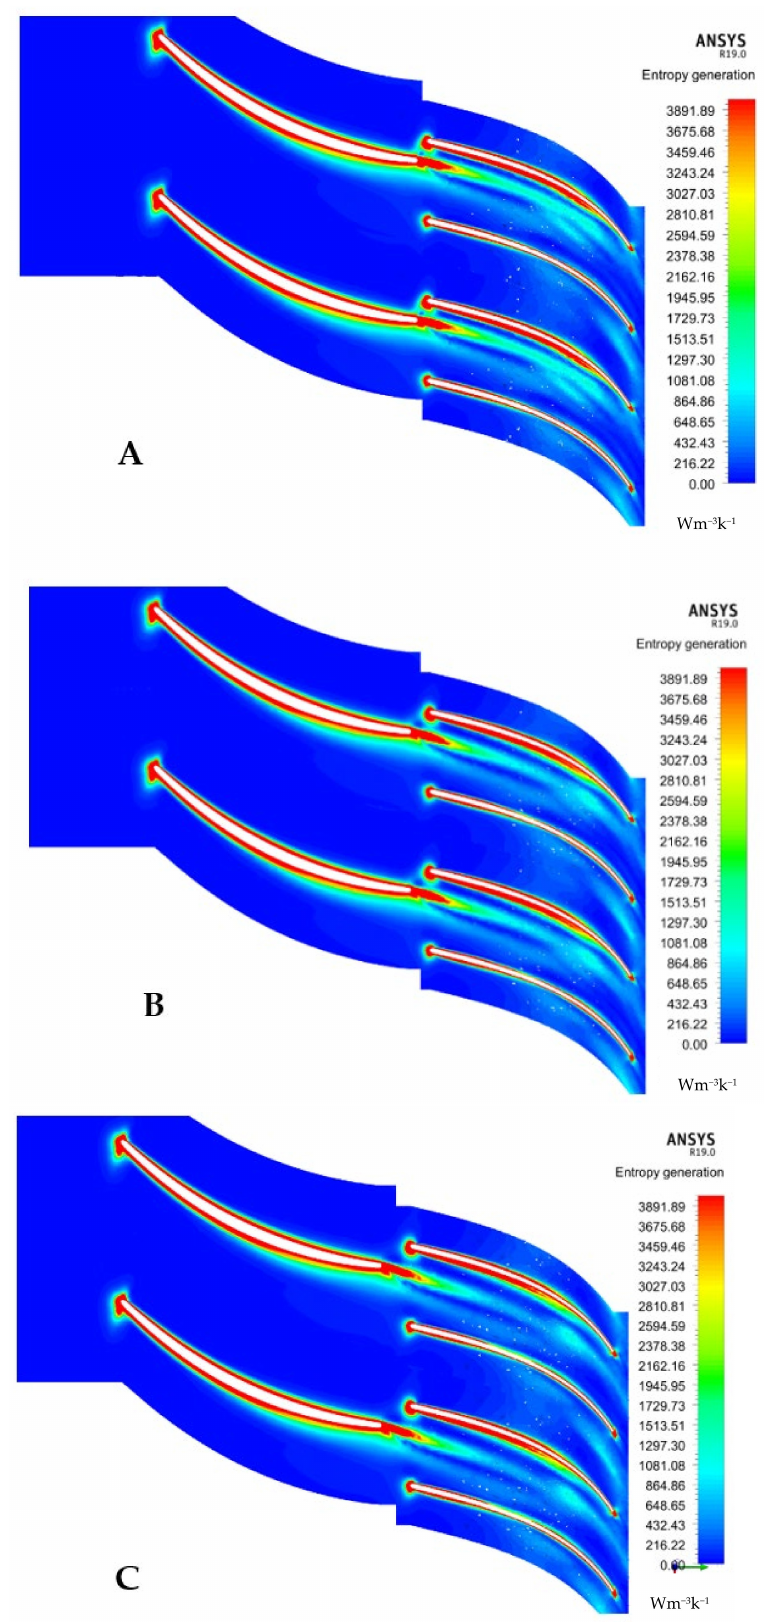
Figure 25. Entropy generation map at 50% span, 25% clock. Axial gap 0.5 mm ( A ), 1 mm ( B ), and 1.5 mm ( C ), m r =